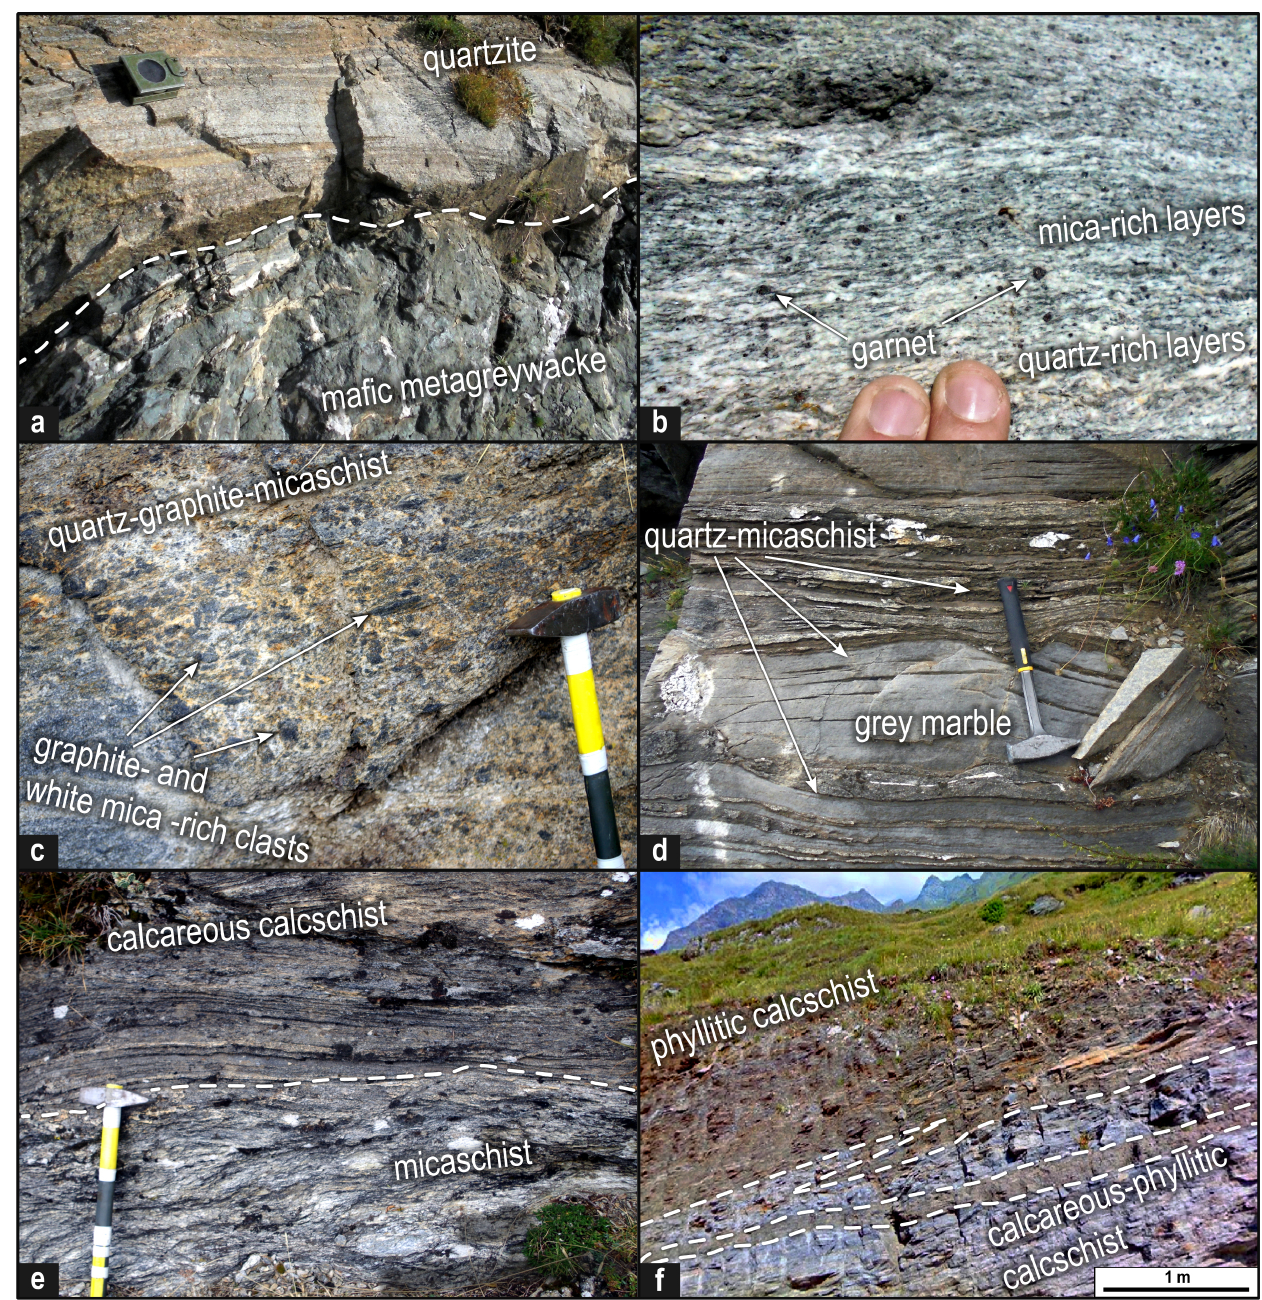
Figure 5. ( a ) Stratigraphic (primary) contact between mafic metagreywacke, with a relict clastic texture and secondary carbonate cement, and quartzite, characterized by a primary alternating of quartz-carbonate-mica (dark) levels and quartz (whitish) layers. 45 ◦ 12 (cid:48) 26.1 (cid:48)(cid:48) N 7 ◦ 09 (cid:48) 15.1 (cid:48)(cid:48) E. ( b ) Details of the garnet-bearing micaceous quartzite, showing different layers enriched in quartz (whitish levels) and white mica (grey levels), both studded of cm-sized garnet. 45 ◦ 12 (cid:48) 28.1 (cid:48)(cid:48) N 7 ◦ 09 (cid:48) 01.6 (cid:48)(cid:48) E. ( c ) Graphite-rich quartz-micaschist, showing several graphite- and white mica-rich irregular clast relicts. 45 ◦ 12 (cid:48) 32.4 (cid:48)(cid:48) N 7 ◦ 09 (cid:48) 49.1 (cid:48)(cid:48) E. ( d ) Gray marble with dm- to cm-sized quartz-bearing micaschist layers, representing the transitional contact between marble and underlying quartzite. 45 ◦ 12 (cid:48) 27.0 (cid:48)(cid:48) N 7 ◦ 09 (cid:48) 33.0 (cid:48)(cid:48) E. ( e ) Overturned contact between calcareous calcschist and micaschist. The former shows alternating cm-sized carbonate-rich and phyllosilicate-rich layers, which appear interrupted along the contact. Micaschist is enriched in quartz, showing a modest graphite (and rarely carbonate) content. 45 ◦ 12 (cid:48) 28.7 (cid:48)(cid:48) N 7 ◦ 08 (cid:48) 44.3 (cid:48)(cid:48) E. ( f ) Transitional stratigraphic contact between the phyllitic calcschist and the calcareous-phyllitic calcschist. 45 ◦ 12 (cid:48) 27.6 (cid:48)(cid:48) N 7 ◦ 08 (cid:48) 54.9 (cid:48)(cid:48)